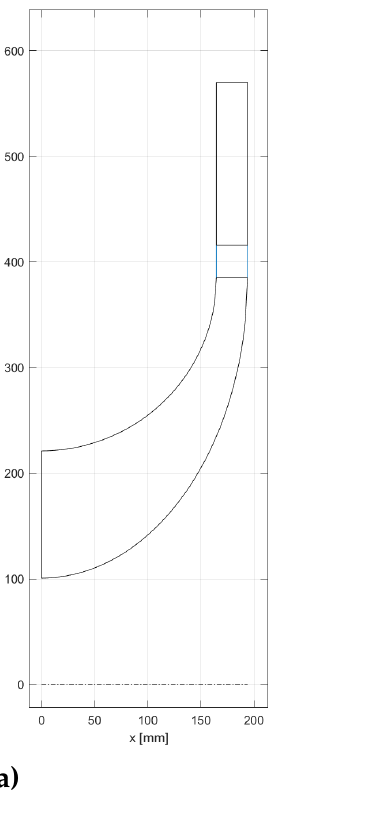
Figure 3. Compressor geometry: ( a ) meridional channel, impeller outlet ( b ) and inlet ( c ) velocity mean triangles. 1: impeller inlet, 2: impeller outlet